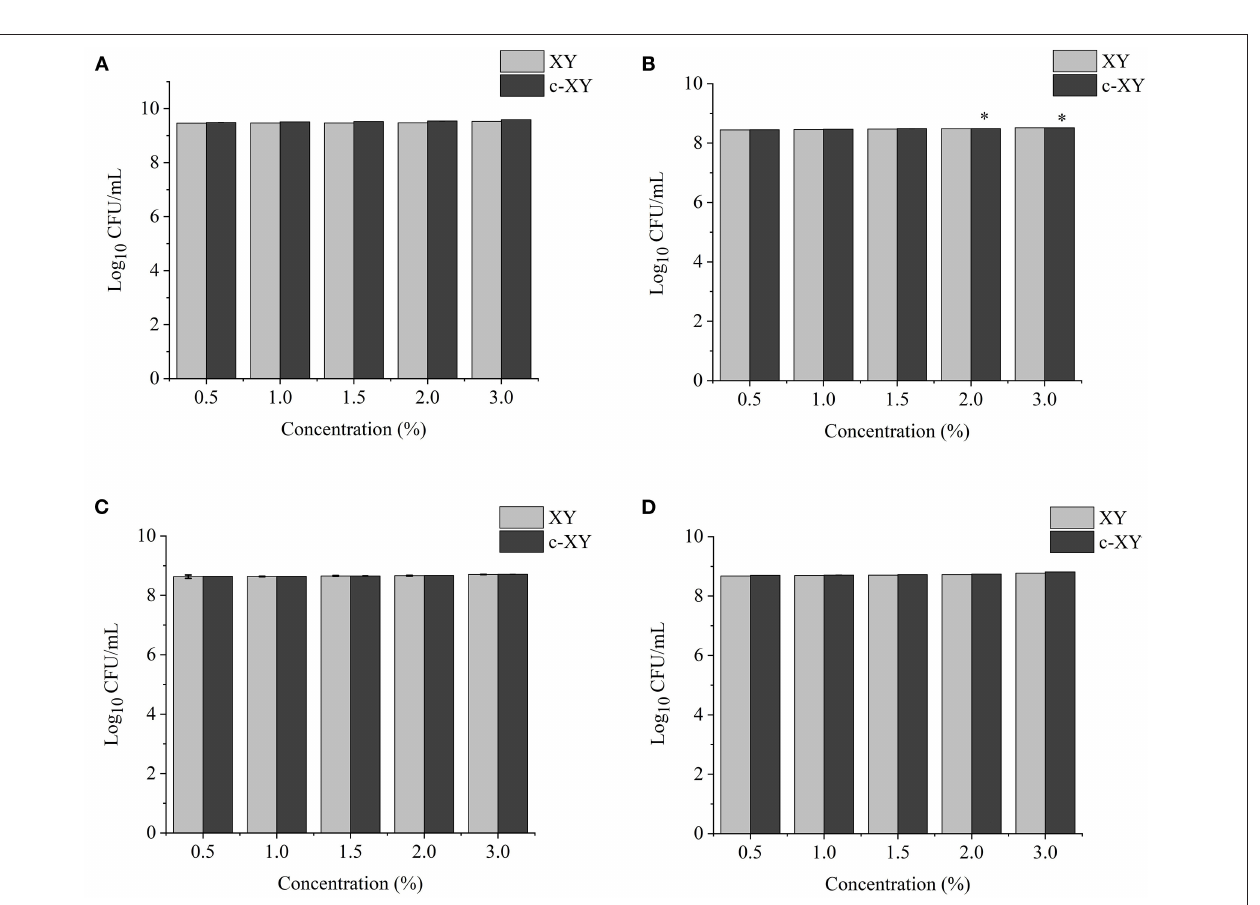
higher concentrations (2.5 and 5 mM), the secretion of fluid and electrolytes occurred, and glucose and fructose absorption was impaired